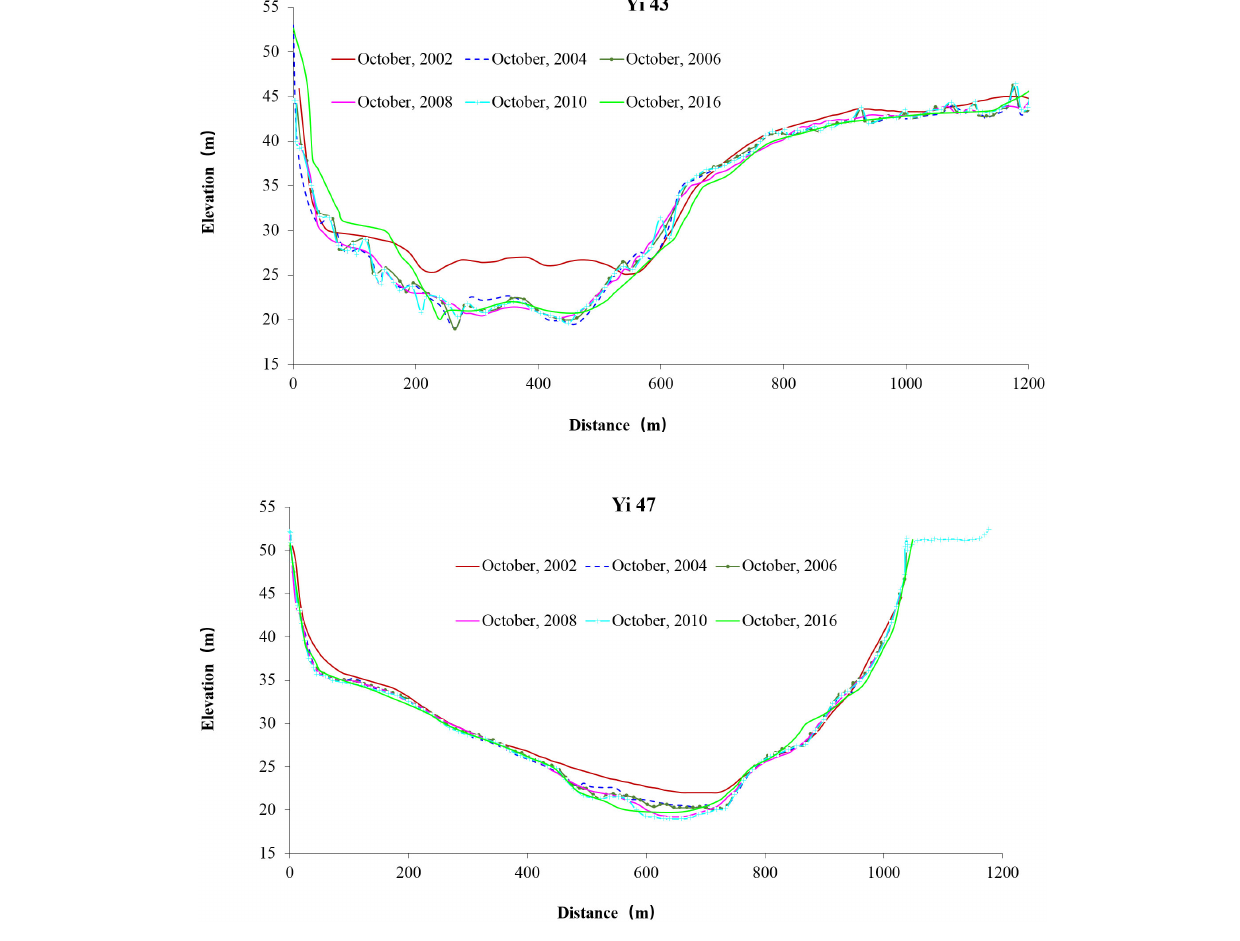
FIGURE 5 | Typical cross-section changes of the Yichang